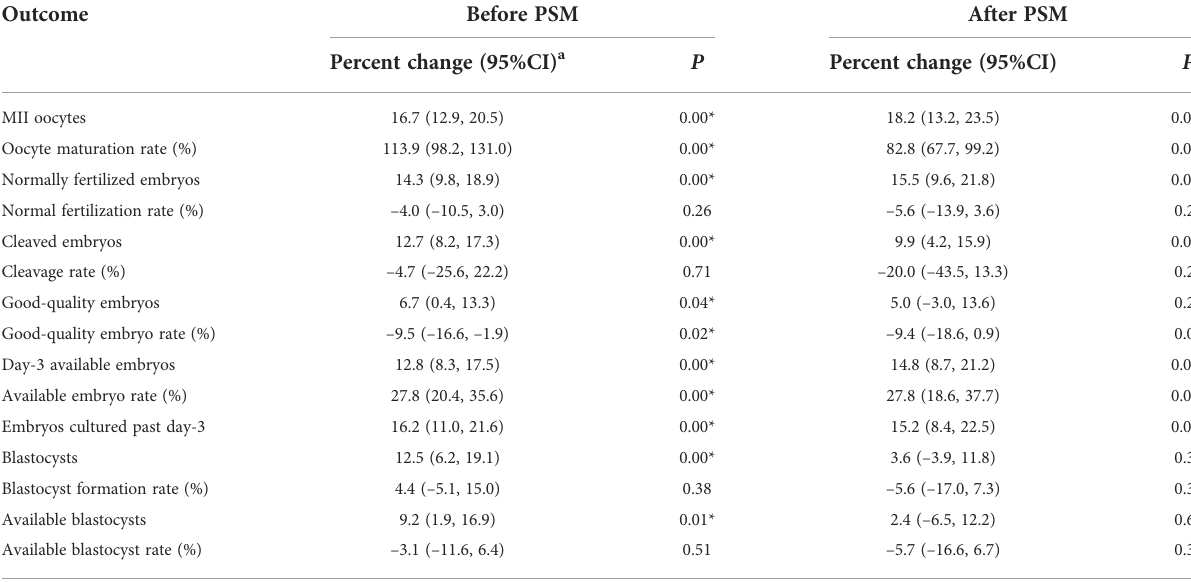
TABLE 2 Intermediate reproductive outcomes of women undergoing only ICSI versus women undergoing ICSI with R-IVM. Outcome Before